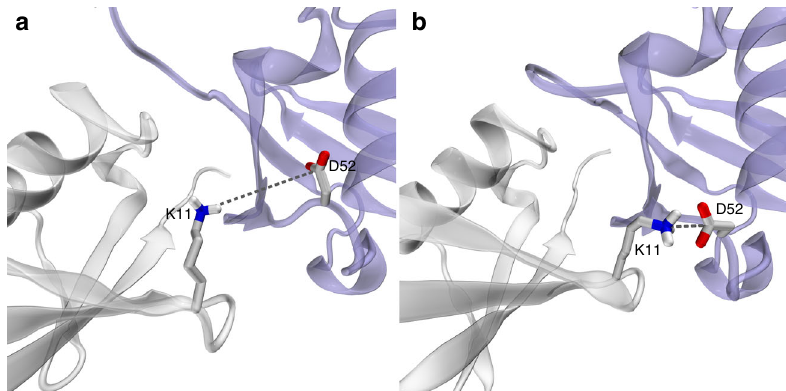
Fig. 5 Dynamic ion pair K11 chainA – D52 chainB interaction in cubic-PEG-ub crystals. a Crystallographic structure of cubic-PEG-ub (PDB entry 3N30 45 ) and b a selected frame from cubic-PEG-ub trajectory. The dynamic disorder in residue K11 chainA is re fl ected in its crystallographic temperature factors; this residue ’ s side chain has not been modeled in our recent structure